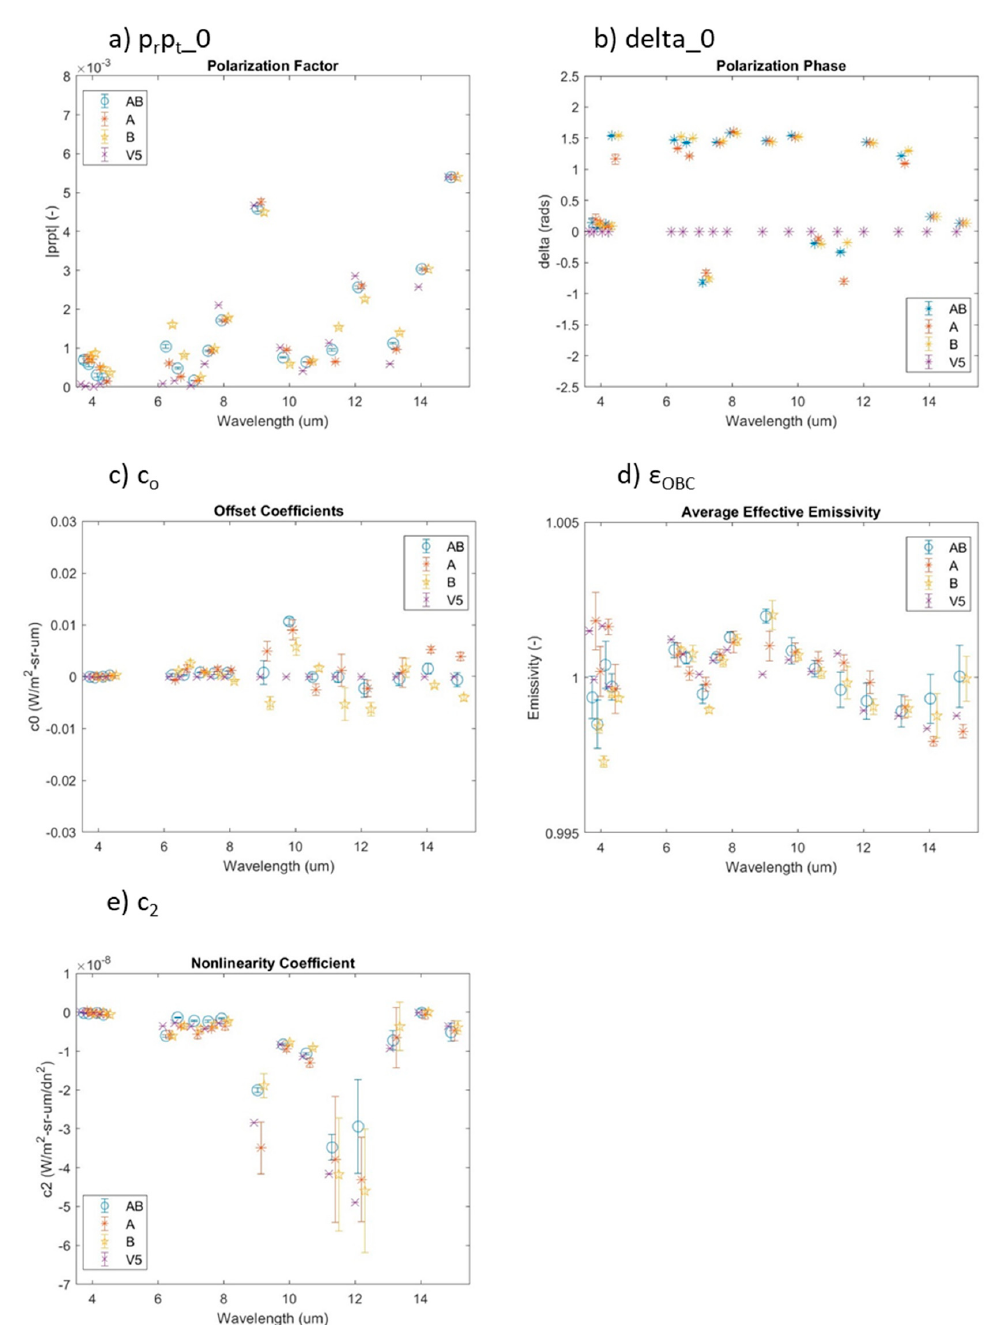
Figure 5. Module average coe ffi cient values for V7 (labeled A, B, and AB for the PV detector sides in use during the test), and V5 (one side per channel). ( a ) Polarization factor of scan mirror and spectrometer interpolated to start of mission. ( b ) Phase of the spectrometer polarization interpolated to start of mission. ( c ) O ff set coe ffi cient. ( d ) E ff ective emissivity. ( e ) Nonlinearity coe ffi cient. Error bars